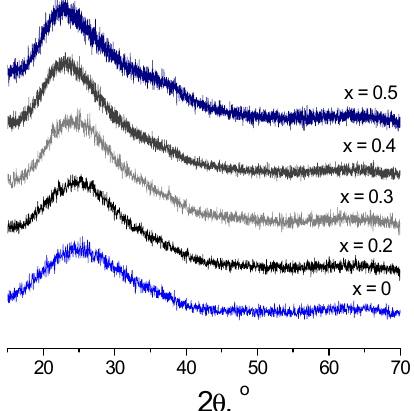
Figure 1. XRD patterns of Li 1.5+x Al 0.5 Ge 1.5 Si x P 3 − x O 12 glasses. DSC analysis at different heating rates (3, 5, 10, 15, and 25 ◦ C min − 1 ) was performed to DSC-curves of 0.1Si glass at 10 ◦ C min − 1 . Bends around 500–530 ◦ C depending on the heating